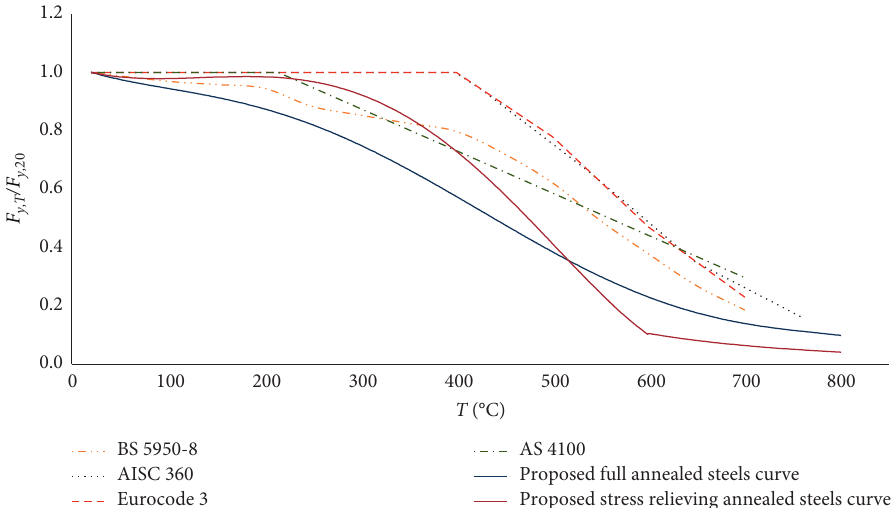
Figure 24: Comparison of the proposed equation curves with code curves for predicting yield strength. Table 9: Recommendation retention factors for the yield strength.